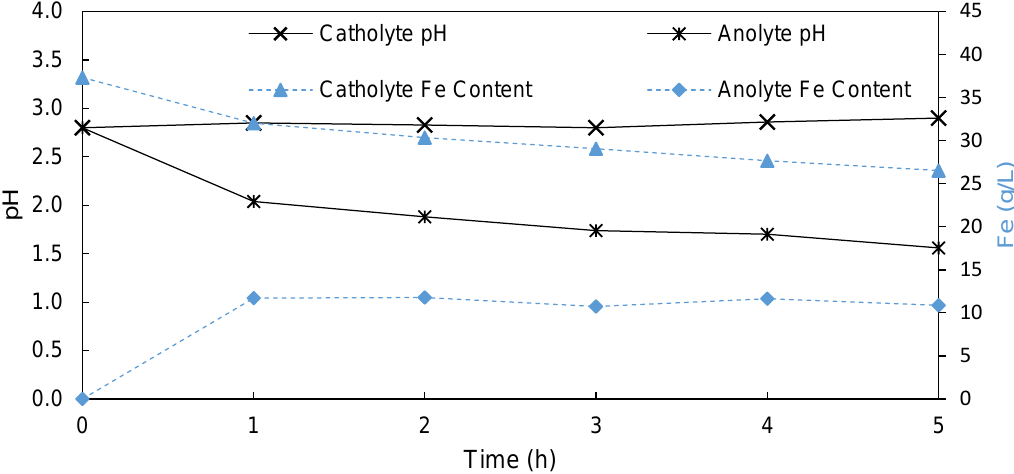
Figure 3. Change in the pH (primary y -axis) and Fe content (secondary y -axis) of the catholyte and anolyte during EW using a Terylene porous membrane as a separator.